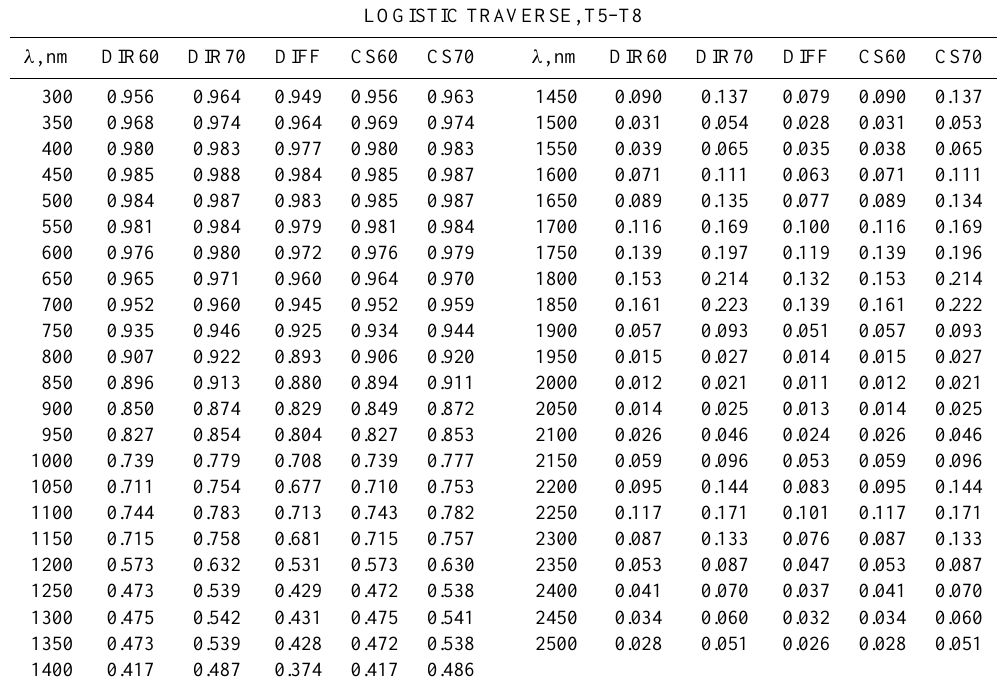
Table A5. Directional hemispherical reflectance of the mean of pits T5 to T8, calculated using the light sources of Table 2. LOGISTIC TRAVERSE,